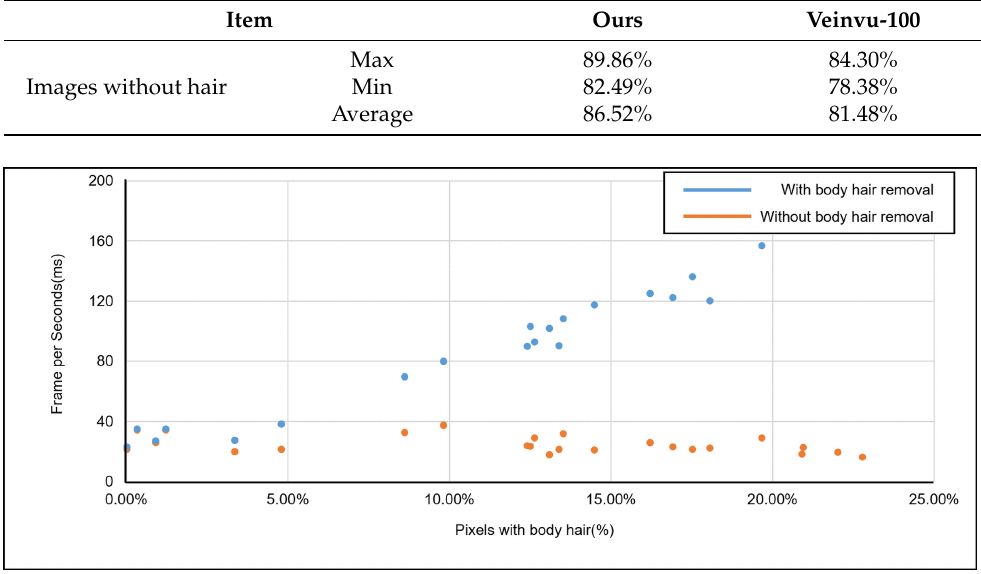
Figure 20. Proposed Algorithm Operation SSIM Measurement Results. Table 4. Proposed Algorithm SSIM Similarity Verification Results.